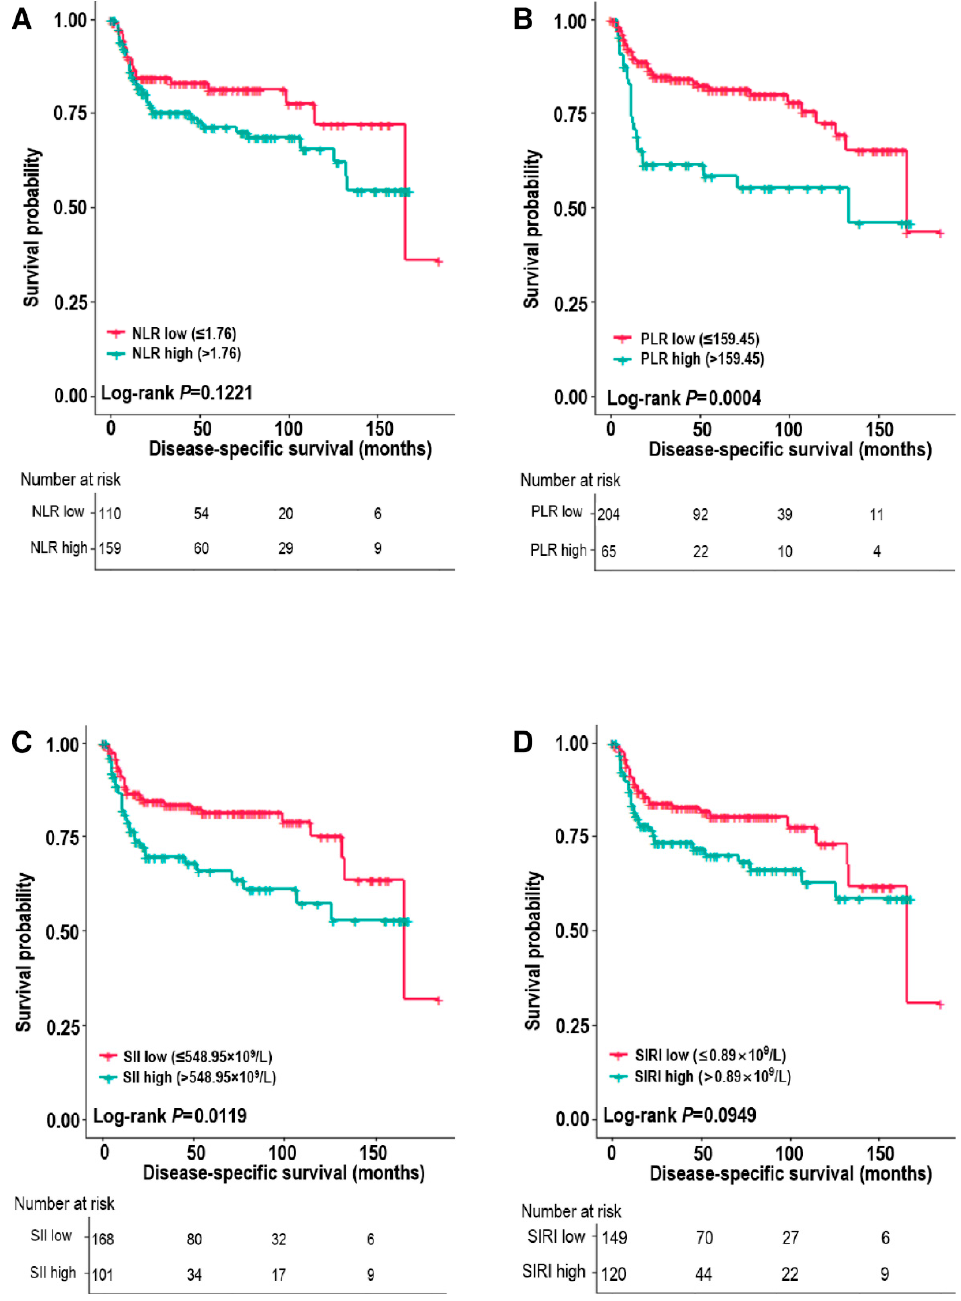
Figure 1. Disease-specific survival estimates (Kaplan–Meier) according to the neutrophil–lymphocyte ratio (NLR) ( A ), platelet–lymphocyte ratio (PLR) ( B ), systemic inflammation index (SII) ( C ), and systemic inflammation response index (SIRI) ( D ).